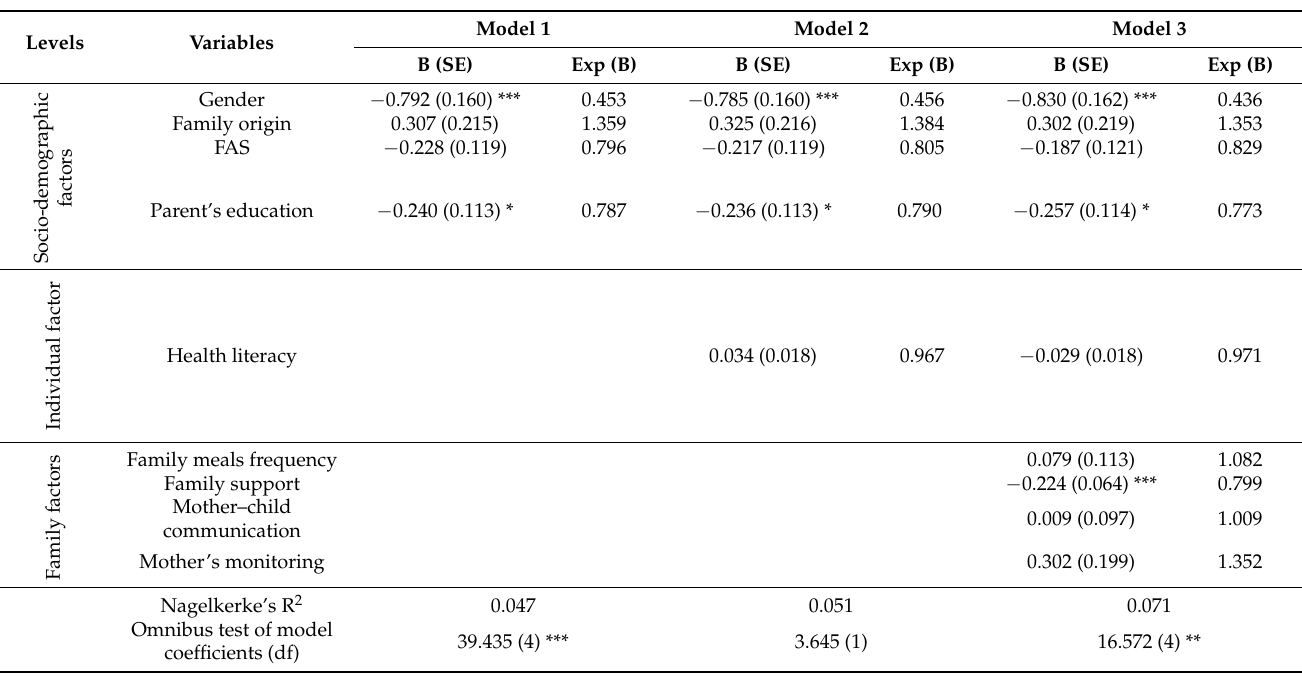
Table 8. Results of multiple binary logistic regression models predicting BMI